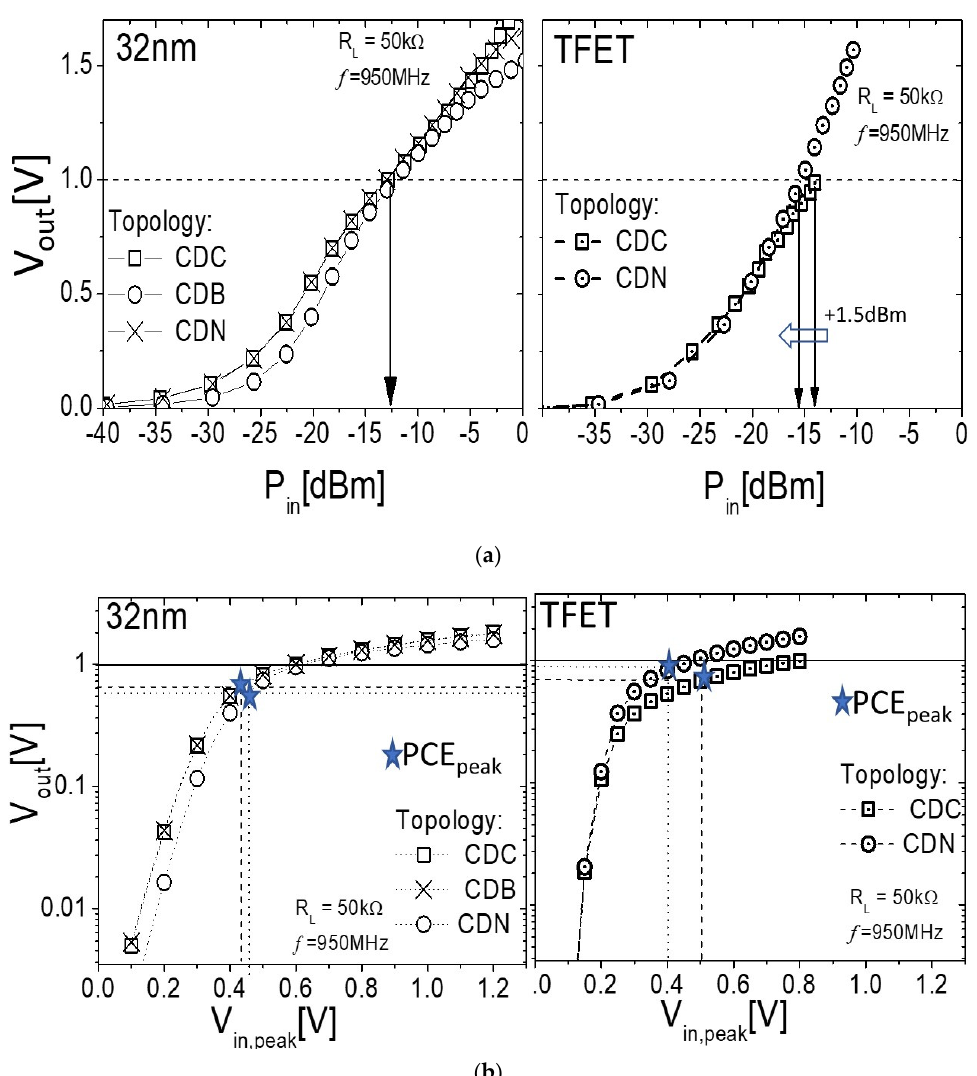
Figure 8. Output Voltage (V out ) as a function of ( a ) the Input Power (P in ) and ( b ) the input Voltage (P in ).